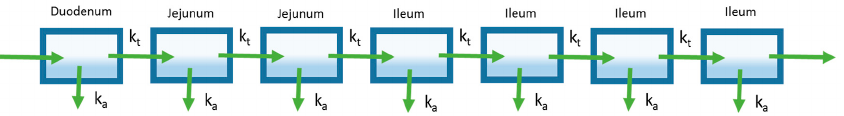
Figure 3. The compartmental absorption and transit (CAT) model extends the mixing tank model to characterize drug transit through the gastrointestinal tract (GIT). Seven well-stirred compartments are used to describe absorption and transit through the small intestine.